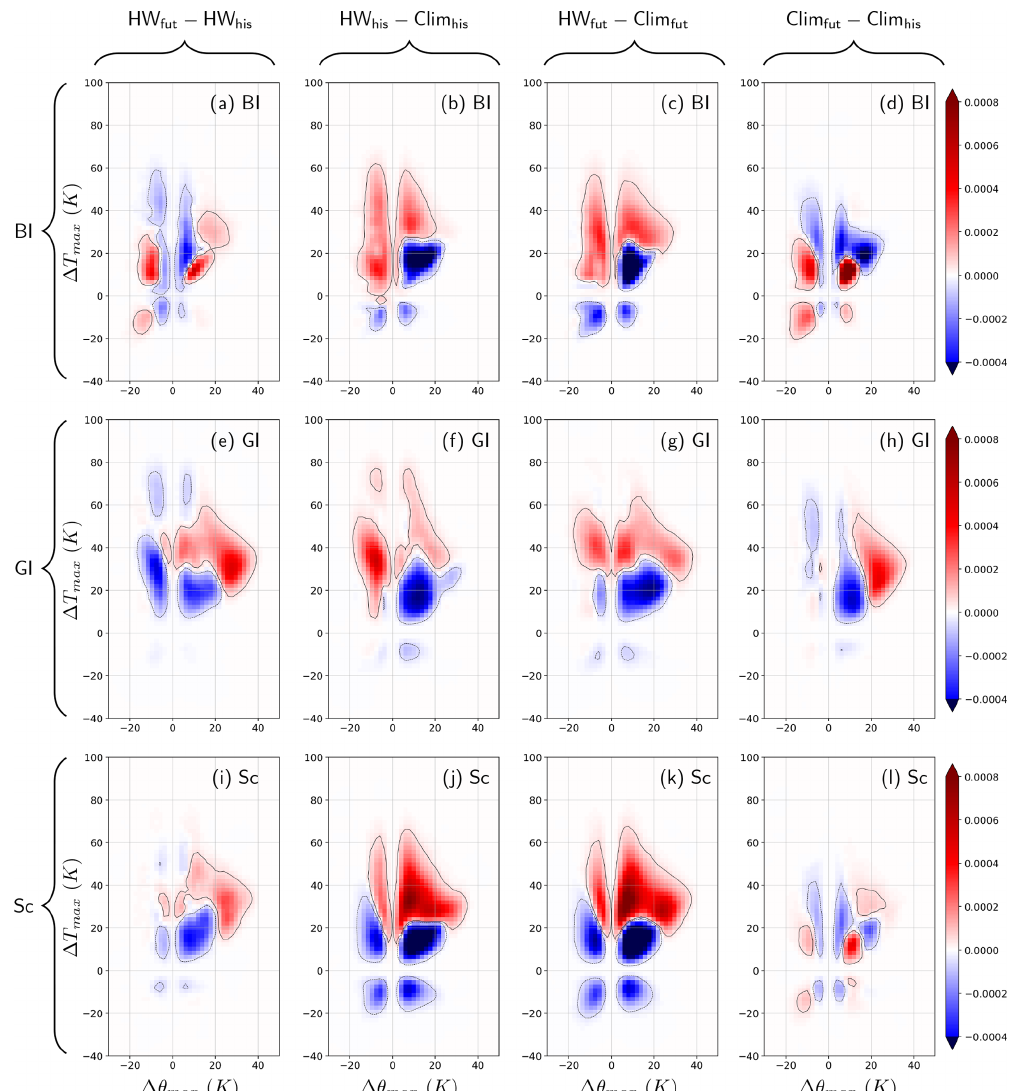
Figure 12. Maximum temperature difference (cid:49)T max along trajectories plotted against the maximum potential temperature difference (cid:49)θ max for (a–d) BI, (e–h) GI and (i–l) Sc. Displayed is the difference between PDFs (as in Fig. 11d). Different regions are shown in rows (four figures per region), and several different plots are shown in columns: (a, e, i) difference between future and historic heatwave distributions; (b, f, j) historic heatwave PDF minus historic climatological JJA PDF; (c, g, k) future heatwave PDF minus future, climatological JJA PDF; and (d, h, l) difference between future and historic climatological JJA PDFs. The probability has been calculated in grid boxes of 2K × 2K, and absolute values of probability differences smaller than < 0 . 000001 are omitted. Solid (dashed) black contour in panel (d) marks a value of + 0 . 00005 ( − 0 . 00005) of the difference in